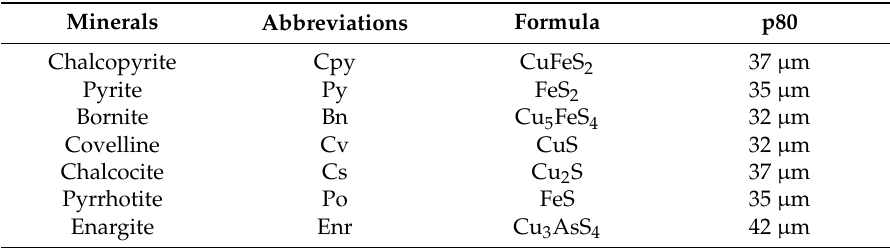
Table 1. List of sample minerals.